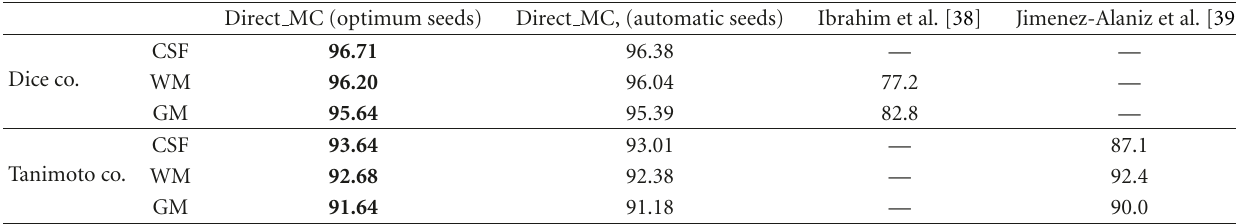
Table 2: Accuracy results for a dataset of brainweb [co.: coe ffi cient].